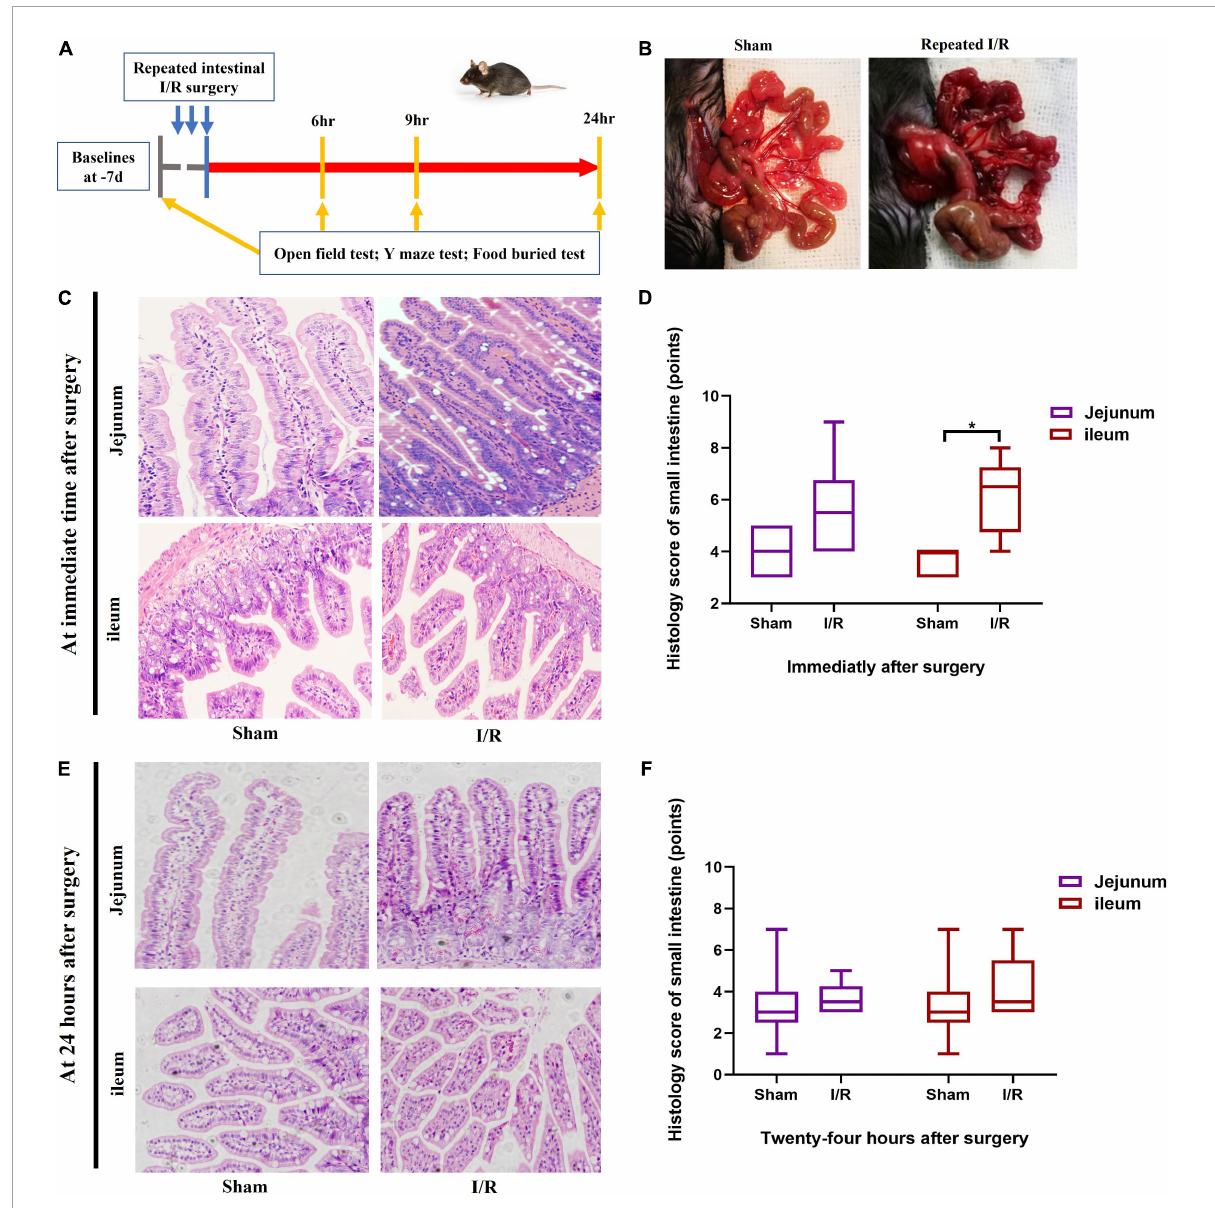
FIGURE1 Experimental protocol and histological assessment on small intestine. (A) Experimental protocol. (B) Small intestine changed due to I/R or sham operation. (C,D) Histological assessment on small intestine immediately after surgery. (E,F) Histological assessment on small intestine at postoperative 24 h. N = 10 per group for behavioral testing, N = 8 per group for histological assessment, * P < 0.05. I/R: ischemia and reperfusion, d: days, hr: